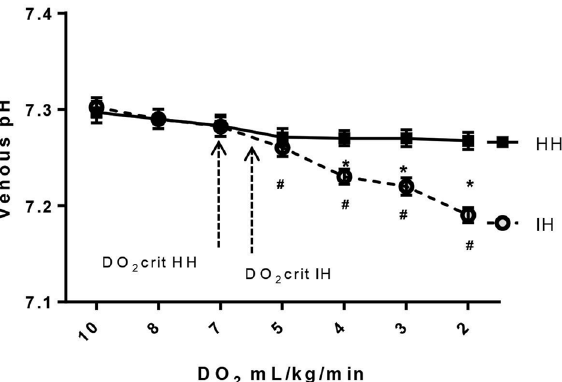
Figure 2. Hindlimb venous pH as a function of hindlimb oxygen delivery (DO 2 ) for ischemic hypoxia model (IH) and hypoxic hypoxia model (HH). * p < 0.006 vs. HH, # p < 0.007 vs. baseline, mixed